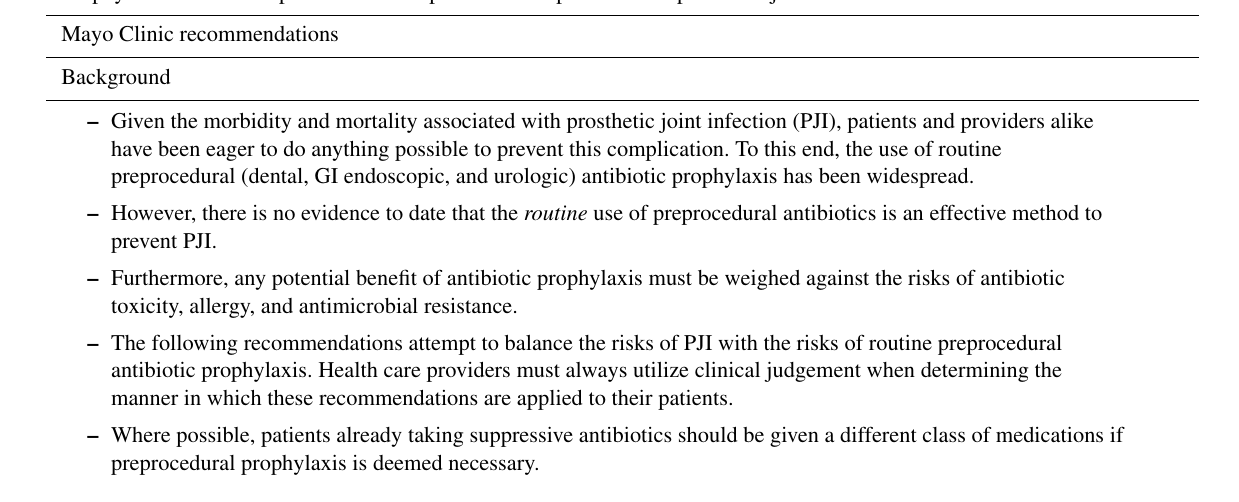
Table 1. Mayo Clinic guidelines on prophylactic antibiotics prior to invasive procedures in patients with prosthetic joints.